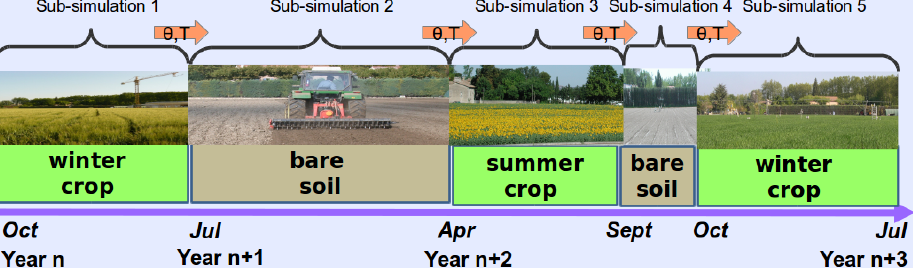
Figure 2. Illustration of the typical succession of winter and summer crops over the Avignon site and implementation of the crop succession in the simulations. θ and T represent soil moisture and soil temperature transmitted from one sub-simulation to the following